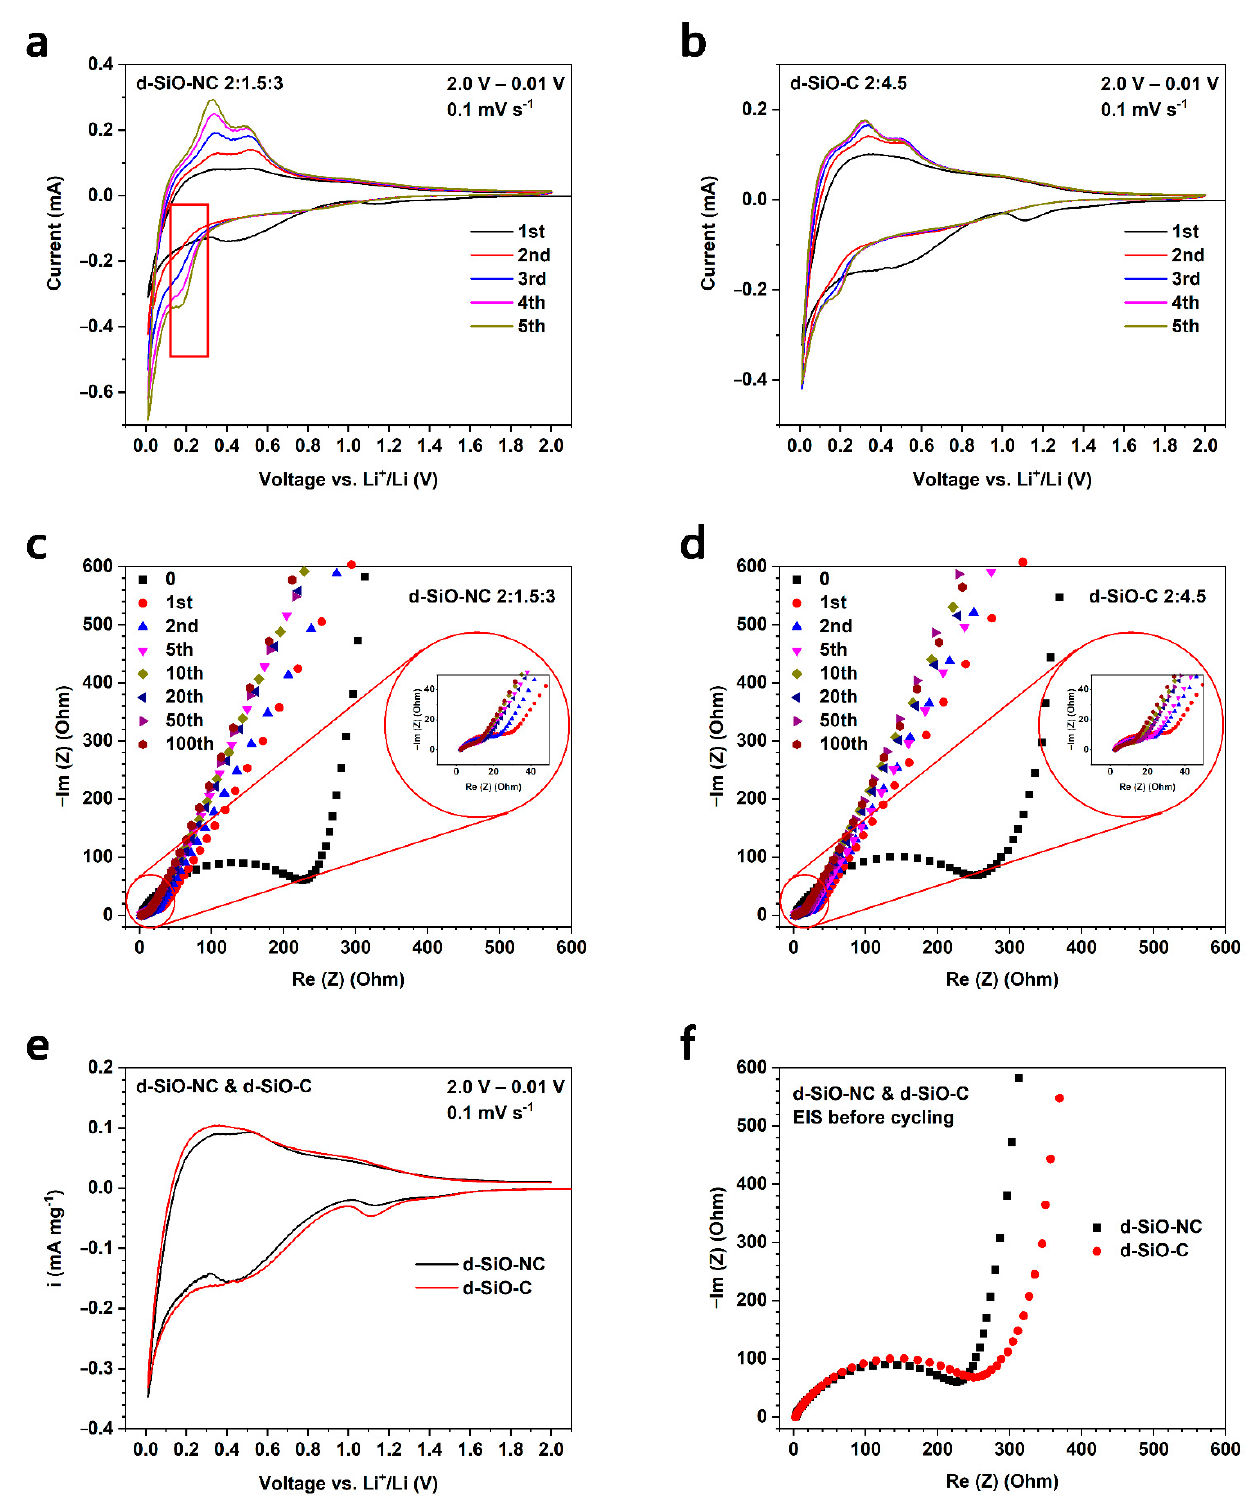
Figure 7. Cyclic voltammetry curve of first 5 cycles of d-SiO-NC (2:1.5:3) ( a ) and d-SiO-C (2:4.5) ( b ). Electrochemical impedance spectroscopy after different cycles of d-SiO-NC (2:1.5:3) ( c ) and d-SiO-C (2:4.5) ( d ). Comparison of first-cycle CV curve ( e ) and EIS spectroscopy ( f ) between d-SiO-NC (2:1.5:3) and d-SiO-C (2:4.5). ( g ) The equivalent circuits of EIS analysis. Table 2. The values of ohmic, solid electrolyte film and charge transfer of d-SiO-C (2:4.5) and d- SiO-NC (2:1.5:3).